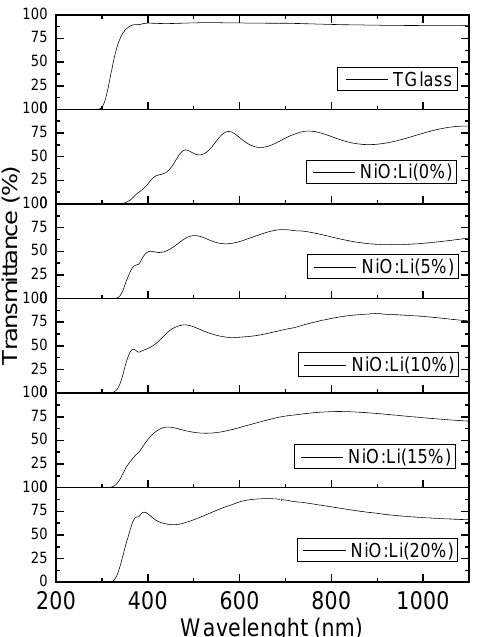
Figure 3. (a ) SEM micrograph for NiO: Li (10%) deposited on glass. ( b ) SEM Cross section image of the same film.